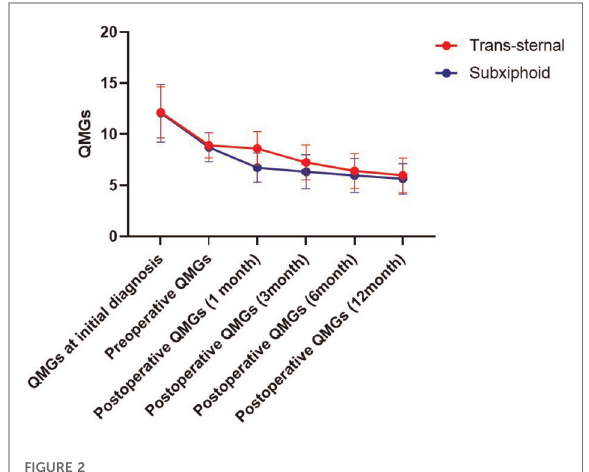
FIGURE 2 Change of QMGs from the initial diagnosis to 12 months follow-up. QMG, quantitative myasthenia gravis score.